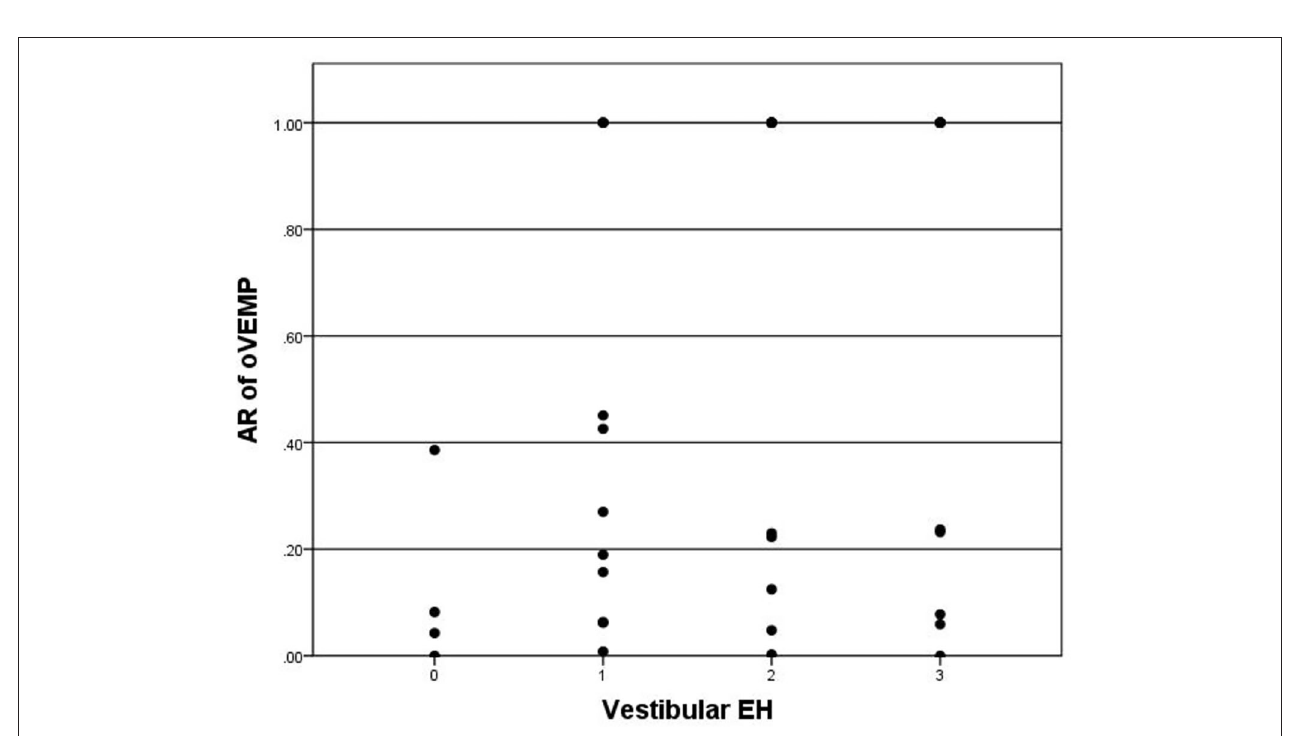
FIGURE 4 | Correlation between grade of vestibular EH (x-axis) and AR of oVEMP (y-axis). The positive correlation is insignificant ( p = 0.098).